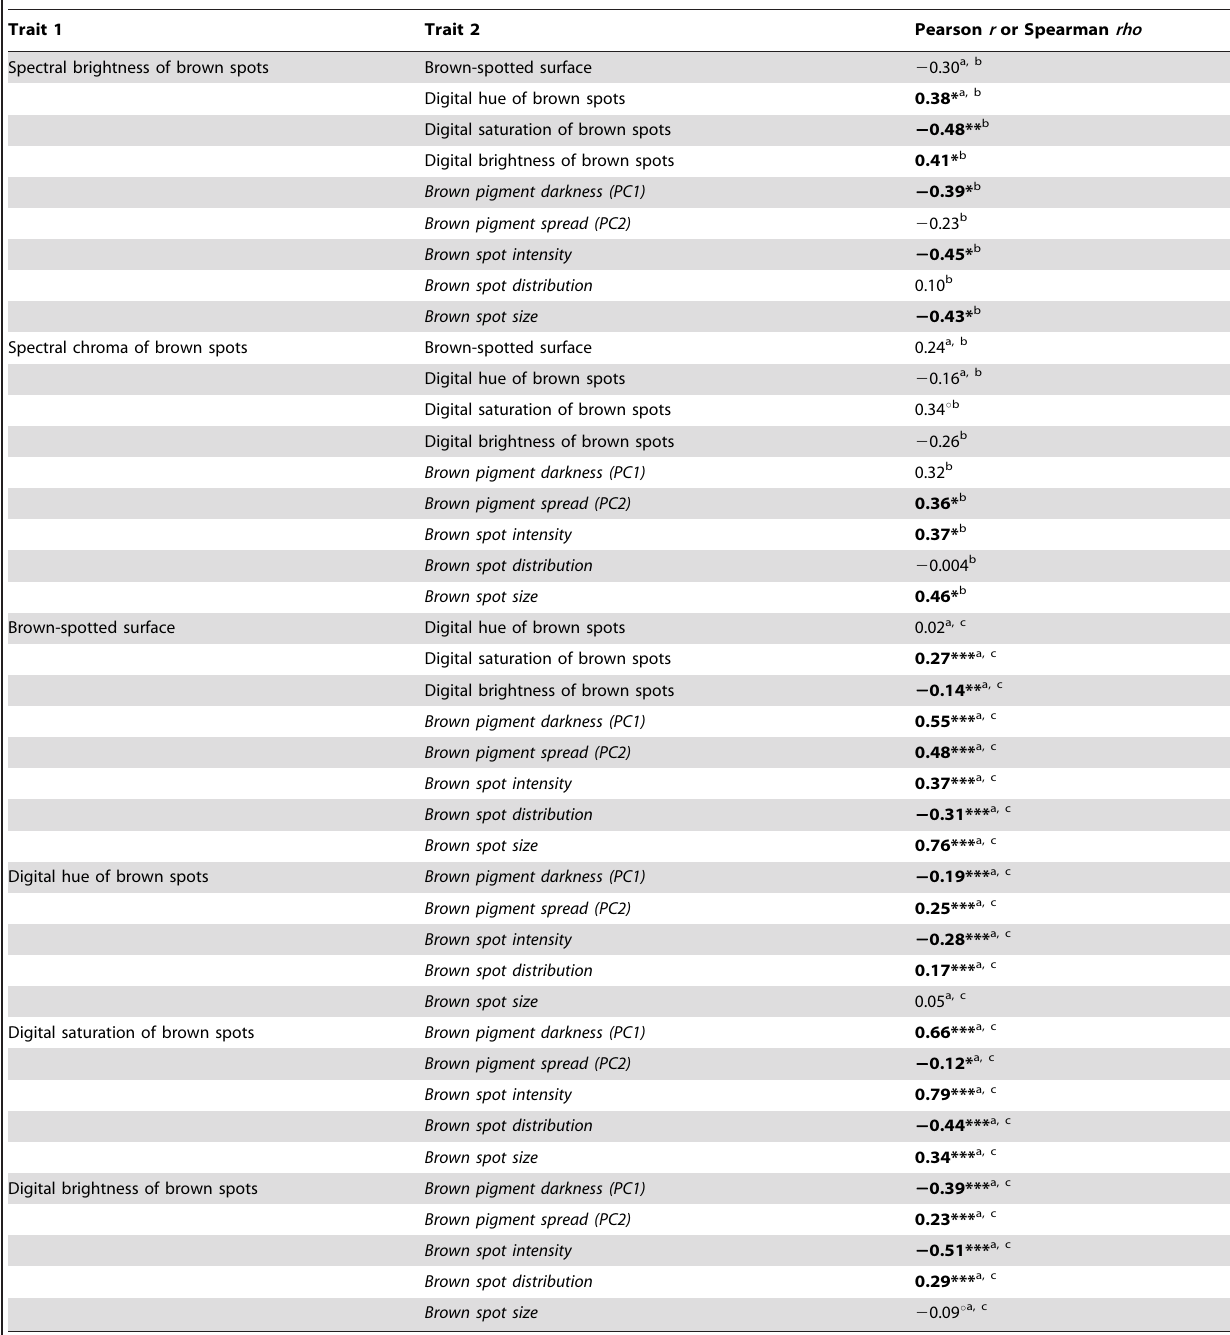
Table 1. Correlations between brown eggshell-color traits.